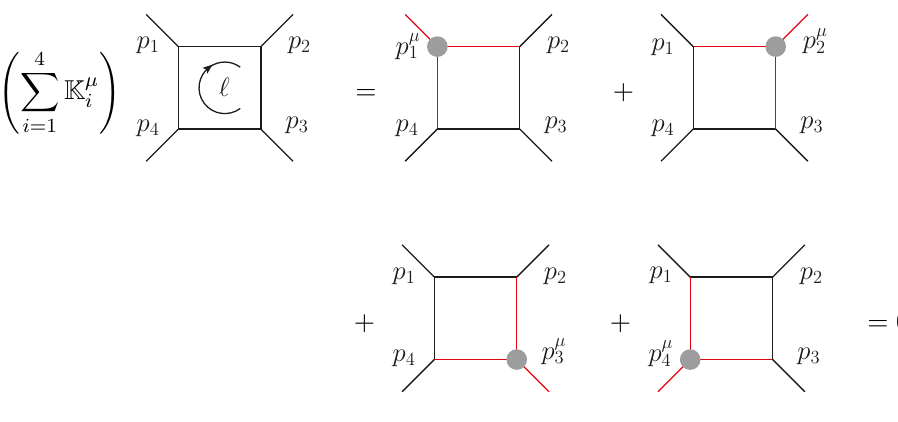
Figure 3 . Cancellation of the conformal anomalies of the 6D zero-mass box. The momenta of the highlighted lines are